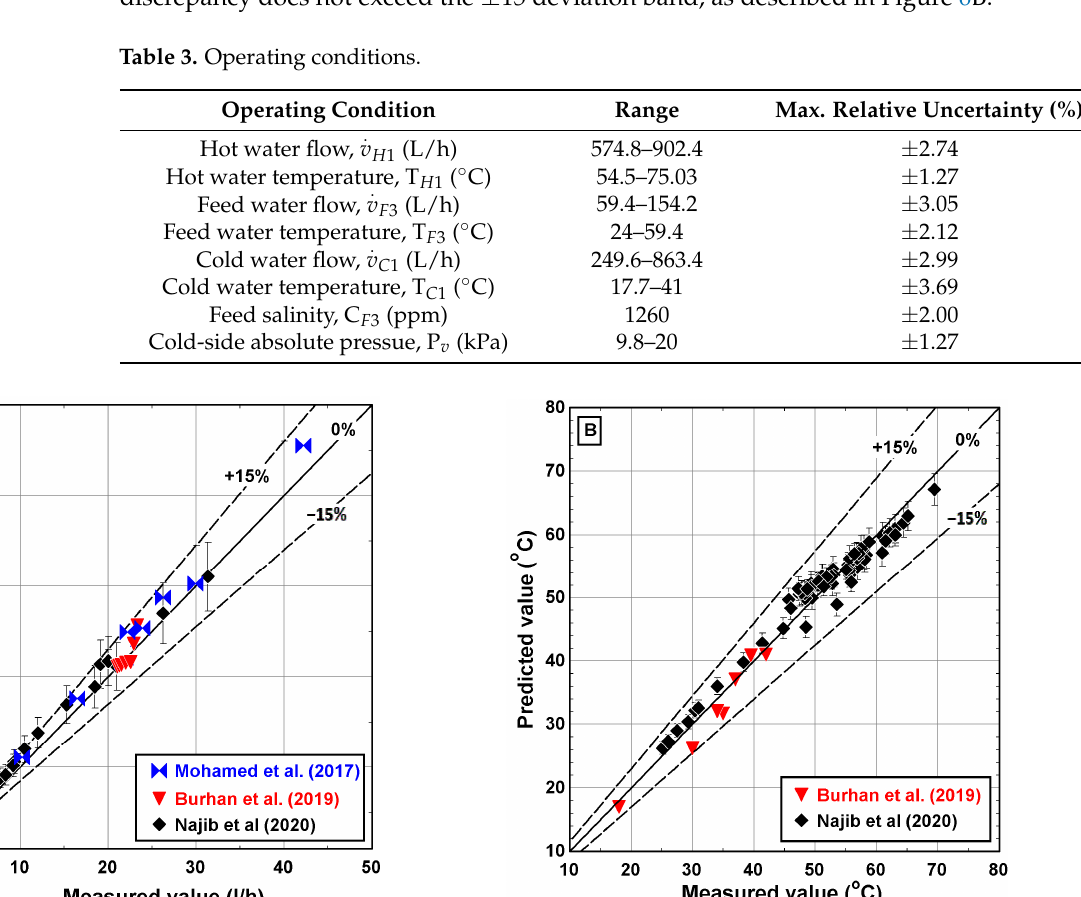
Figure 6. Comparison between experimental measurements and numerical predicted values of the mathematical model for ( A ) distillate water flow and ( B ) mathematical model for ( A ) distillate water flow and ( B ) temperatures.